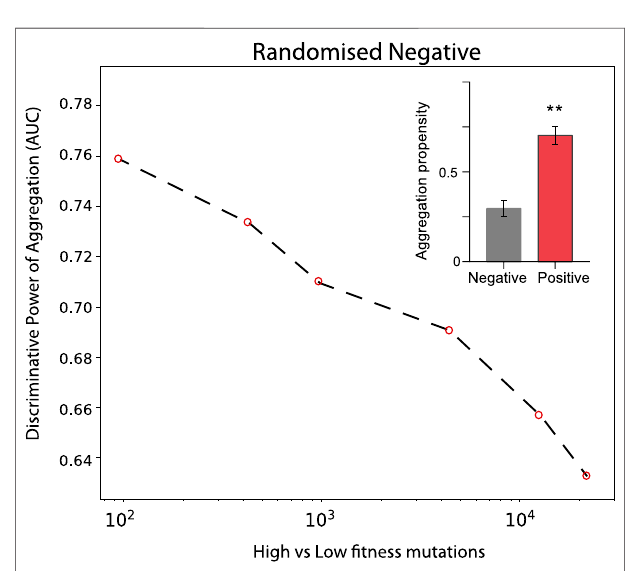
FIGURE 4 | Deep mutational scanning experiments of TDP-43 mutants expressed in S. cervisiae using a random negative set. The AUC values increase progressively with the experimental signal strength. Double mutants are analysed. In the insets, we show the aggregation propensities of mutations associated with the highest (top 100) and random (100 cases) fi tness scores (**, p -value < 0.01, Kolmogorov-Smirnoff test).